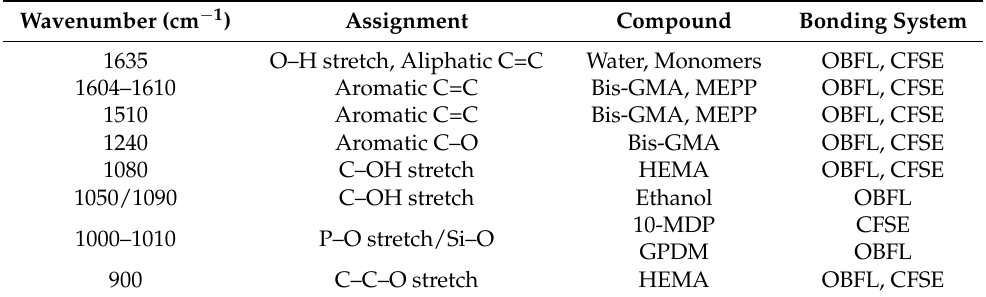
Table 3. IR assignments for R groups of monomers in OBFL and CFSE primers and adhesives.